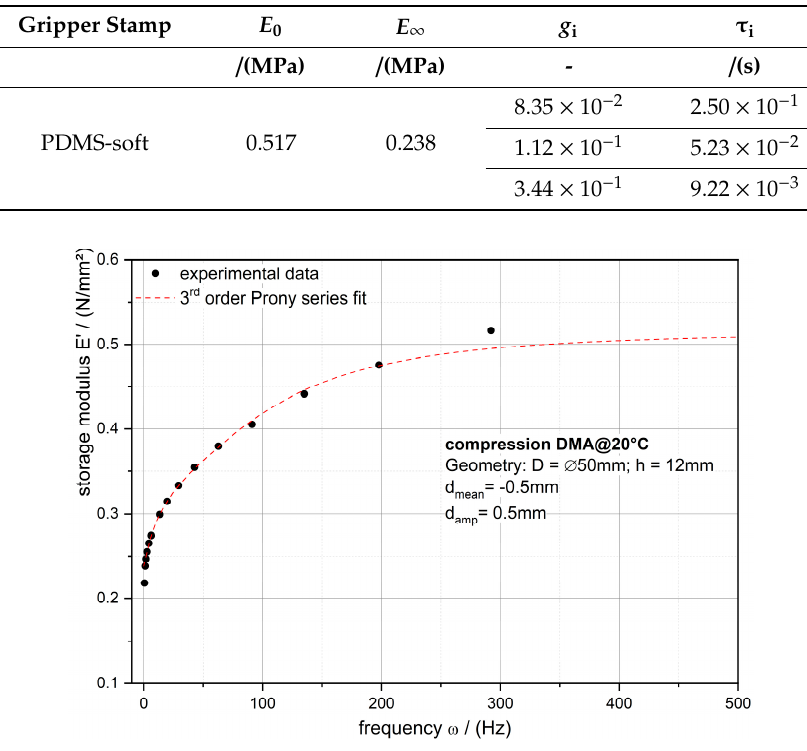
Figure 5. Loss factor tan δ over storage modulus E’ characteristic of the investigated formulation at 20 °C under compression DMA loading procedure . Table 1. Prony parameters of PDMS-soft formulation . Table 1. Prony parameters of PDMS-soft formulation.